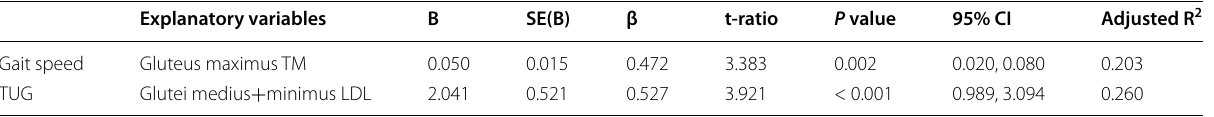
B partial regression coefficient, SE Standard error, β Standardized partial regression coefficient, CI Confidence interval, R 2 Coefficient of determination, TUG Timed Up-and-Go test, TM , segmented total muscle cross-sectional area, LDL Low-density lean tissue